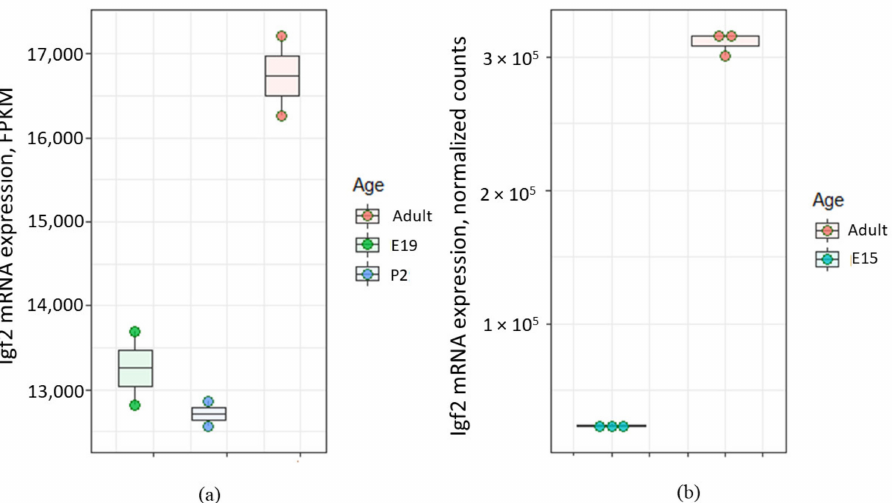
Figure 2. Levels of Igf2 mRNA in the choroid plexus of rats of different age according to Gene Expression Omnibus data repository. ( a ) Igf2 expression level in the choroid plexus from embryonal day 19 (E19), postnatal day 2 (P2) and adult rat according to the data from [63,64]. FPKM (fragments per kilobase of exon model per million reads mapped); ( b ) Igf2 expression level in the choroid plexus from embryonal day 15 (E15) and adult rat according to the data from